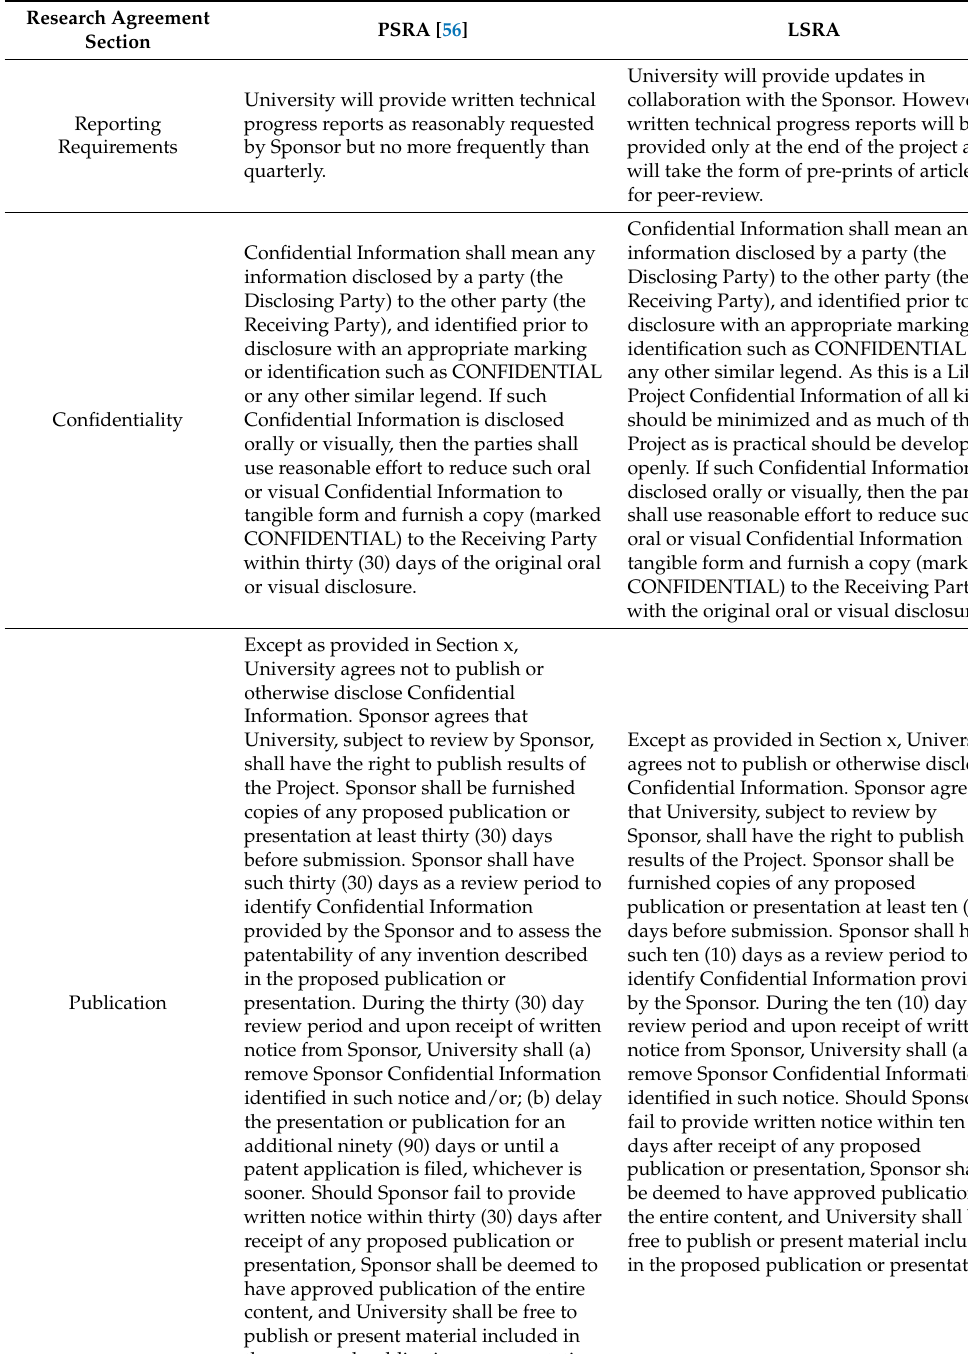
Table 1. The core differences between a standard research agreement used at most universities and one meant to encourage libre research. Section x refers to the section in a specific agreement for the MTU example it is